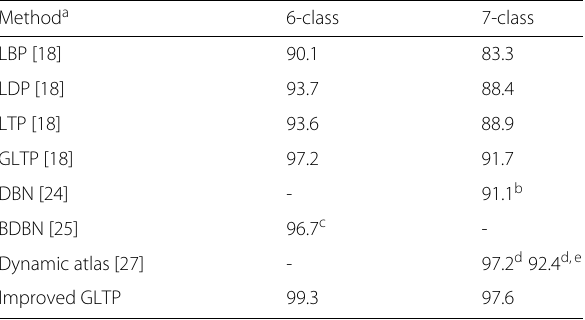
a 10-fold cross-validation unless otherwise stated b 7-fold cross-validation c 8-fold cross-validation d Person independent